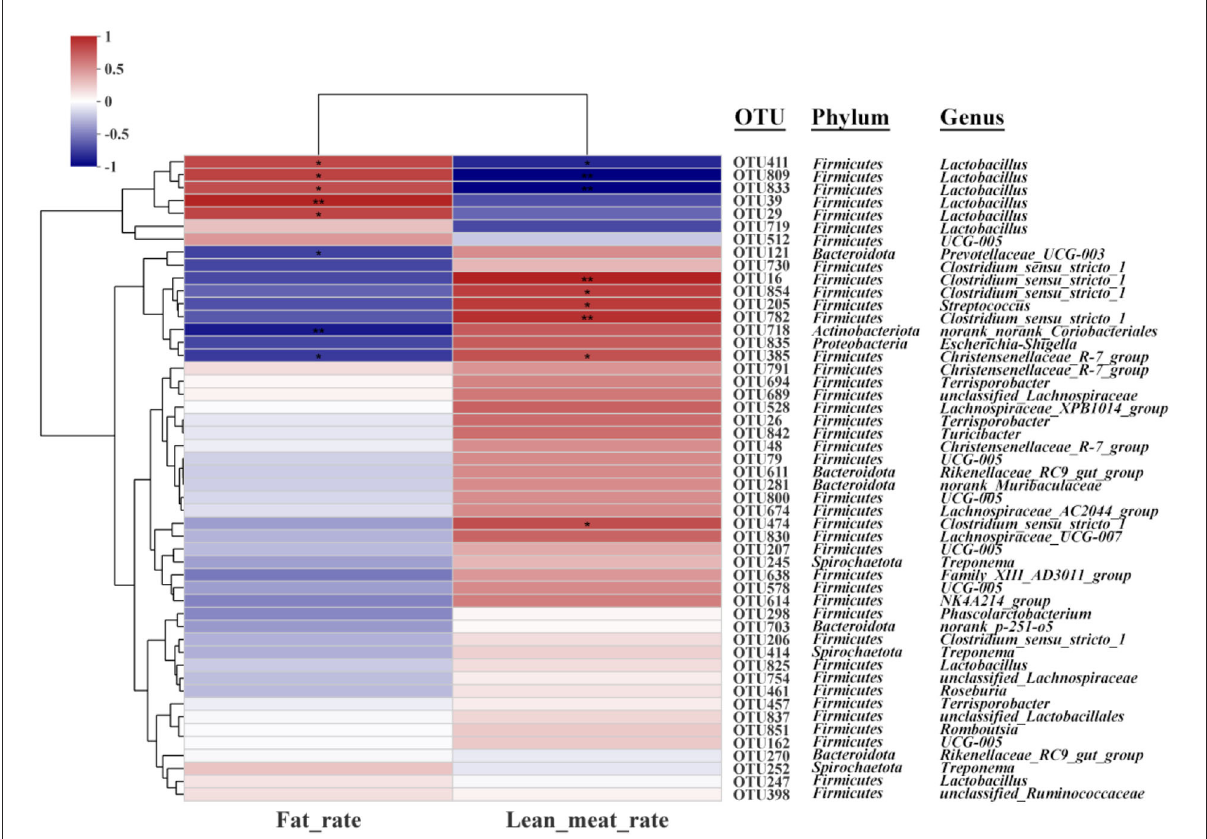
FIGURE8 Spearman’s correlation analysis between gut microbiota (OTU level) and carcass traits (fat rate and lean meat rate). * P < 0.05; ** P < 0.01.